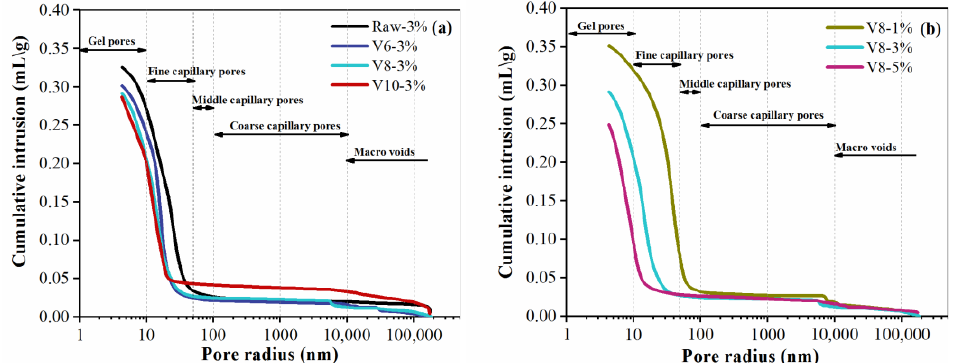
Figure 11. The pore-size distribution of hardened specimens at 28 d: effect of BFS fineness ( a ) and effect of NC dosage ( b ).